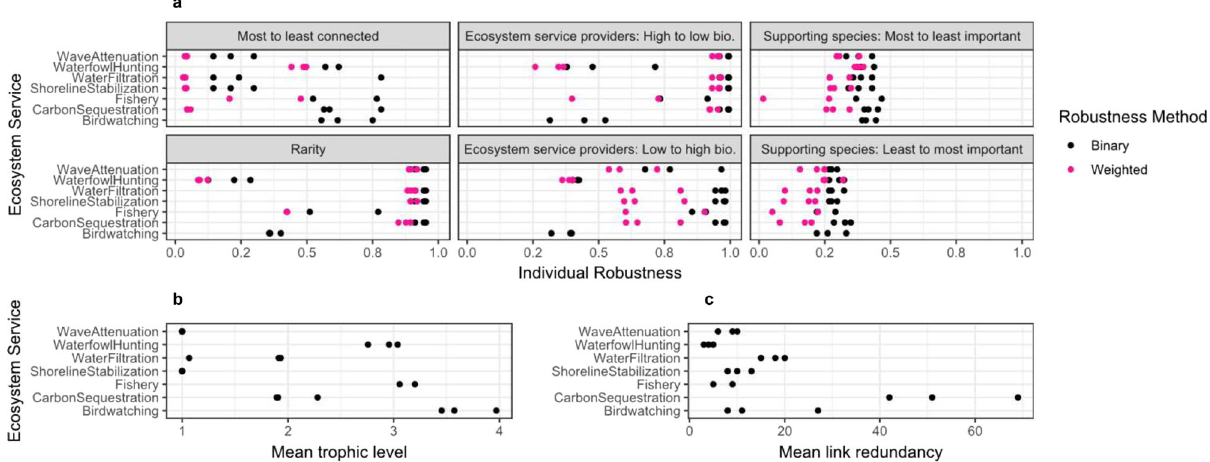
Fig. 6 Individual ecosystem service robustness varies by trophic level and link redundancy. a Individual ecosystem service robustness across the three salt marsh systems and sequences: most to least connected, ecosystem service providers: high-to-low biomass, supporting species: most-to-least important, rarity, ecosystem service providers: low-to-high biomass, supporting species: least-to-most important. Individual ecosystem services respond differently to species across sequences. Pink data points represent individual ecosystem robustness values when calculated based on presence – absence of a species and black data points represent individual ecosystem service robustness values when calculated based on biomass. Birdwatching was excluded from the weighted method extension because the relationship between species and service is not proportional to biomass. b Trophic level of each ecosystem service across systems. c Link redundancy of each ecosystem service across systems.